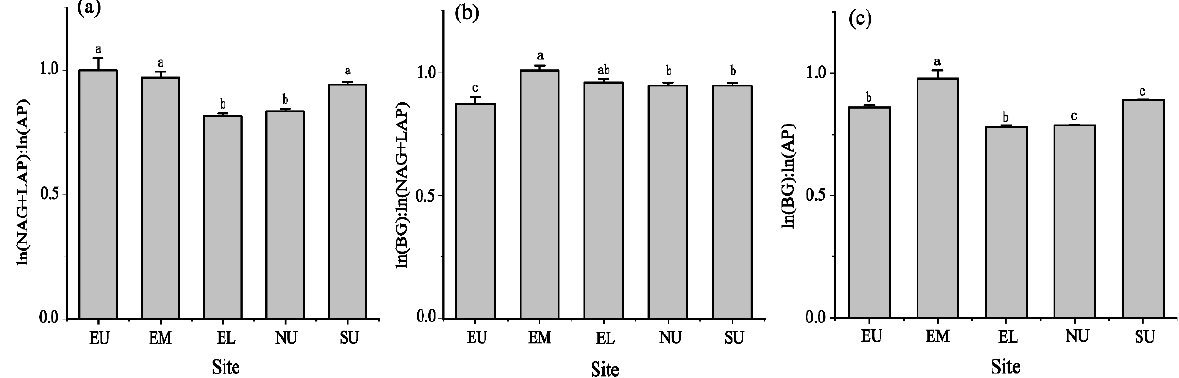
Forests 2022 , 13 , x FOR PEER REVIEW 8 of 13 Figure 3. Soil enzyme stoichiometric ratios under different site conditions. C/N eea ( a ), C/P eea ( b ), N/P eea ( c ). Letters above error bars indicate significant differences at p < 0.05.